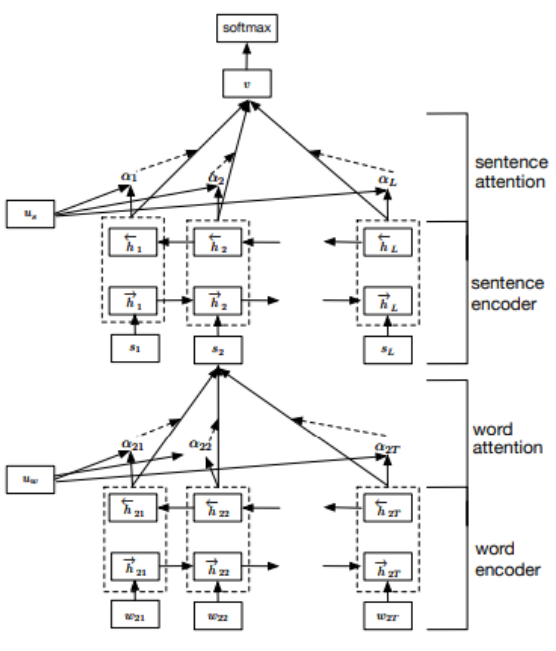
Figure 3. Hierarchical Attention Network